Question: Sum up the contents of this chart in one sentence.
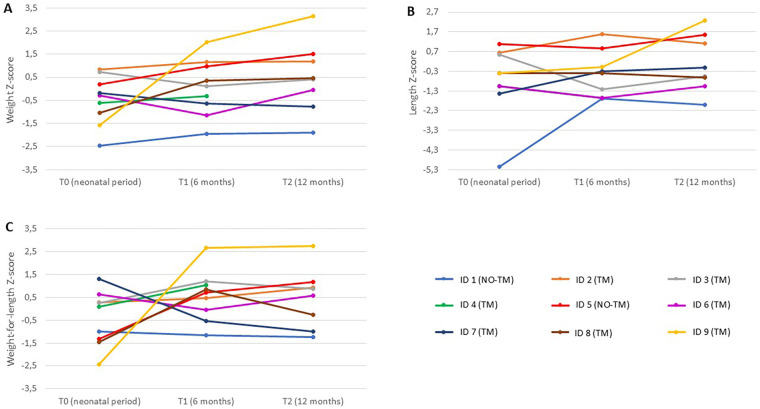
Answer: Anthropometric parameters Z-scores trends of each patient (ID 1-9) at T0 (neonatal period), T1 (6 months of age) and T2 (12 months of age) according to the world health organization growth charts ( 15 ). (A) : weight Z-score; (B) : length Z-score; (C) : weight-for-length Z-score. ID, identification number; TM, received nutritional consultations through telemedicine; NO-TM, did not receive nutritional consultations through telemedicine.